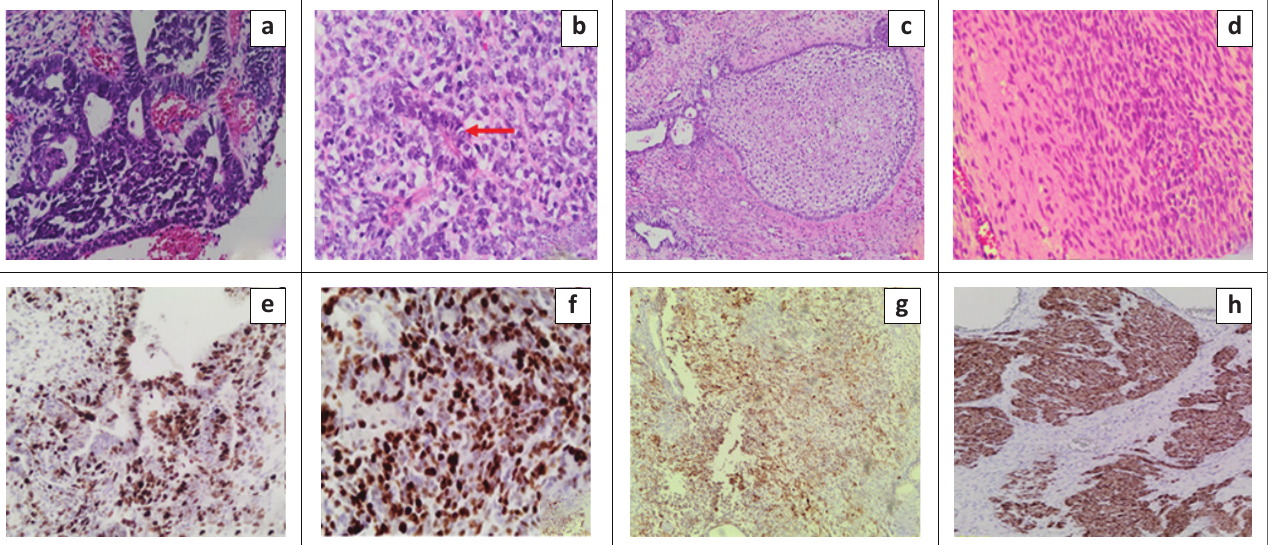
FIGURE 5: Pathological examination showed (a) adenocarcinomatous glands; (b) adjacent primitive neuroepithelium with rosette-like structures; and (c) islands of ‘foetal’ clear-cell squamous cells. (d) Shows a malignant spindled smooth muscle component with numerous atypical mitotic figures. (e) Proliferation index (ki67) > 70%. (f and g) Immunoreactivity of neuroepithelium with S100 and CD56, respectively, and (h) desmin positivity demonstrating smooth muscle differentiation.